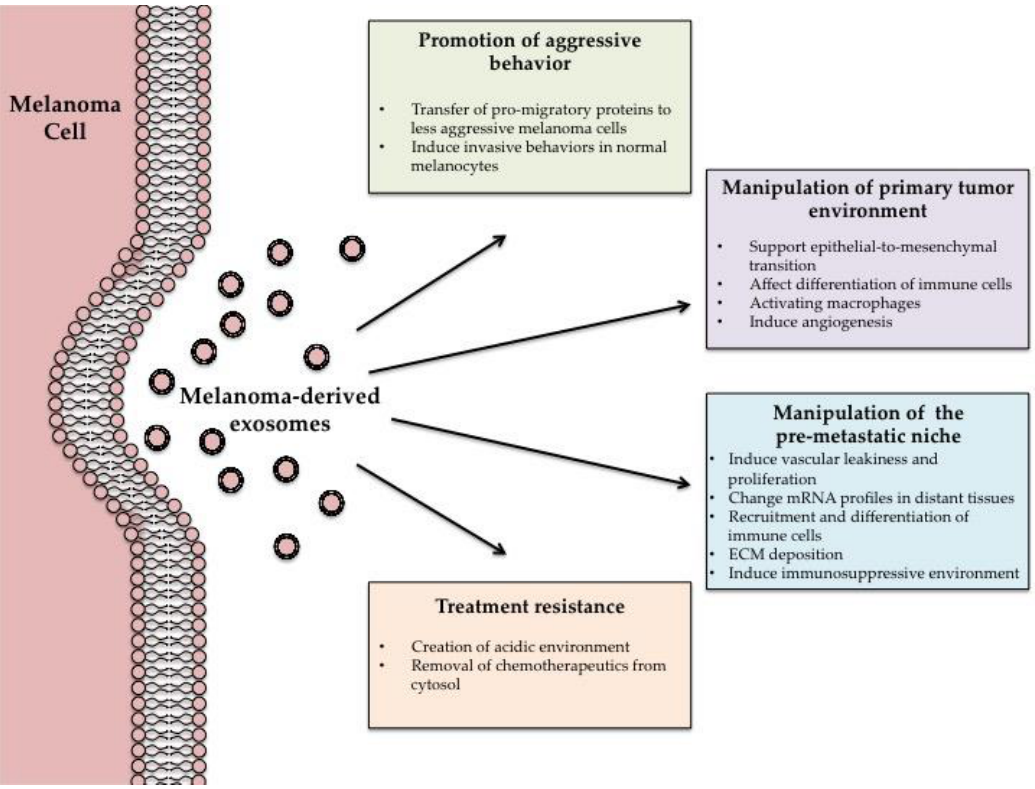
Figure 1. Roles of Exosomes in Tumor Development and Progression: a summary of the proposed roles/functions mediated by melanoma exosomes in tumor development and progression.